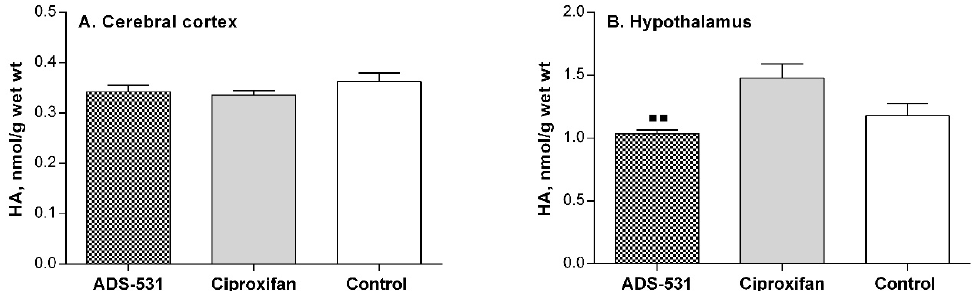
Figure 3. Cerebral histamine concentration in rats subchronically treated with newly synthesized ADS-531 (s.c. 3 mg/kg/daily for 5 days) histamine H 3 receptor antagonist or the reference ciproxifan (s.c. 3 mg/kg/daily for five days). One-way ANOVA and Tukey’s multiple comparisons tests: ciproxifan, p <